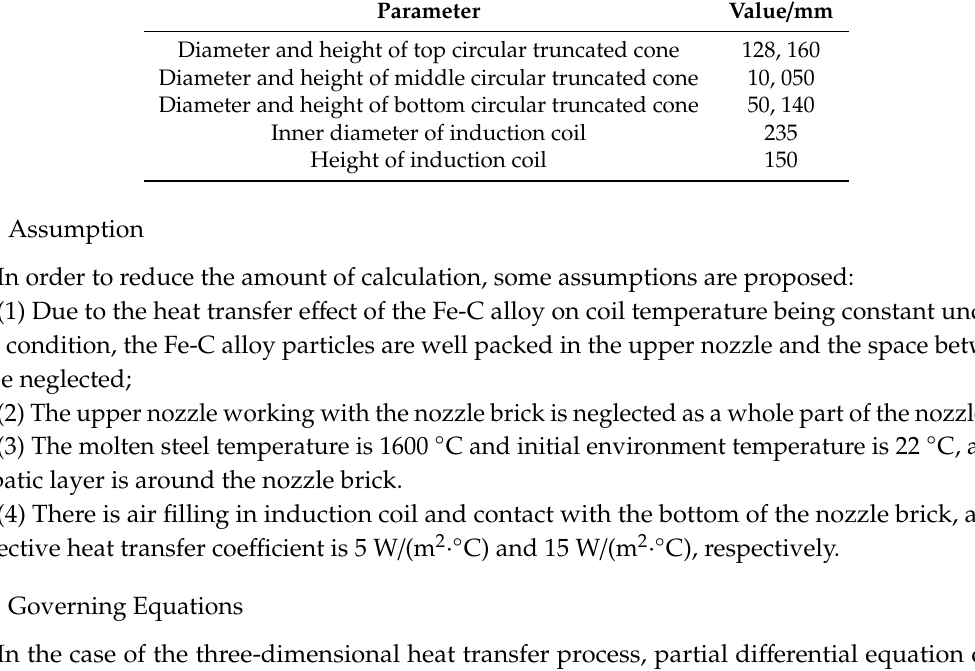
Figure 1. Simulation model: ( a ) three-dimensional model; ( b ) front sectional elevation; ( c ) mesh generation. Table 1. Some sizes of models.